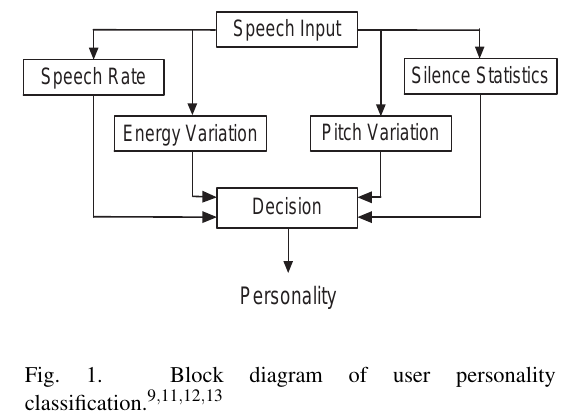
Fig. 1. Block diagram of user personality classification. 9 ; 11 ; 12 ;